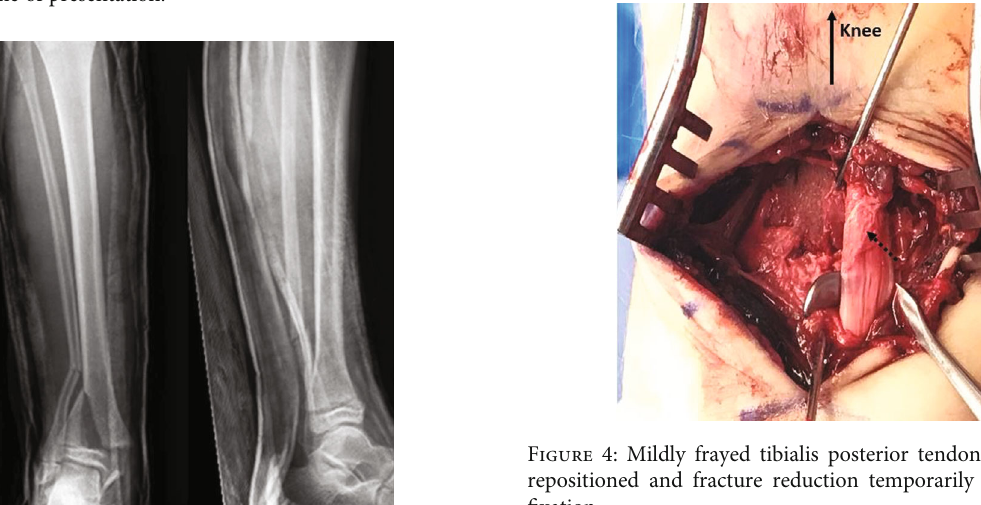
Figure 1: Anteroposterior and lateral radiographs of the ankle fracture at time of presentation.